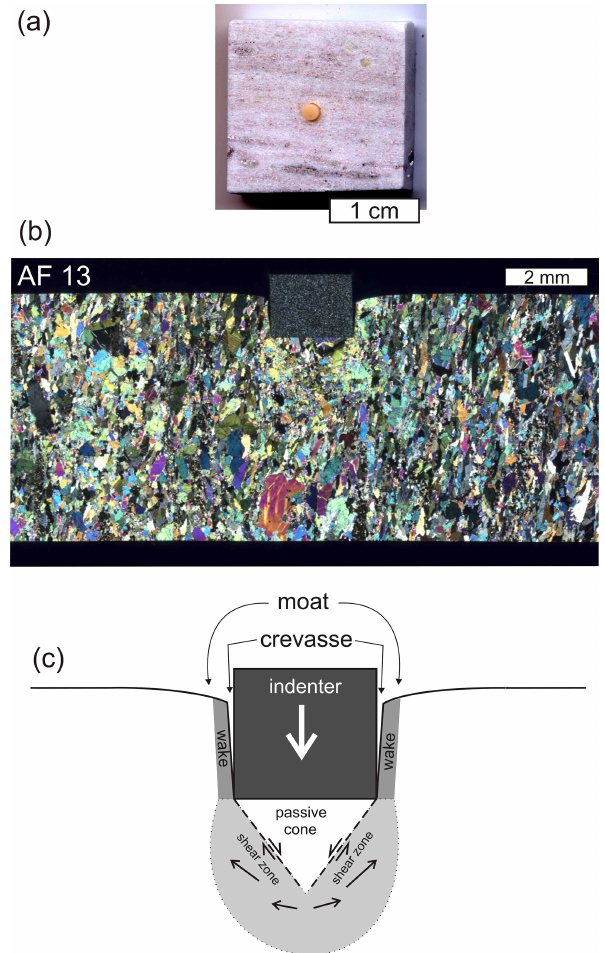
Figure 9. Panel (a) – photography of specimen with alumina in- denter in place; (b) scan of thin section from experiment AF 13 showing modification of anhydrite microfabric around the alumina (fine-grained; low interference colours) indenter; median cut nor- mal to lineation of the starting material; (c) scheme showing moat, crevasse, and passive cone bound by shear zones underneath the in- denter; rotational symmetry is